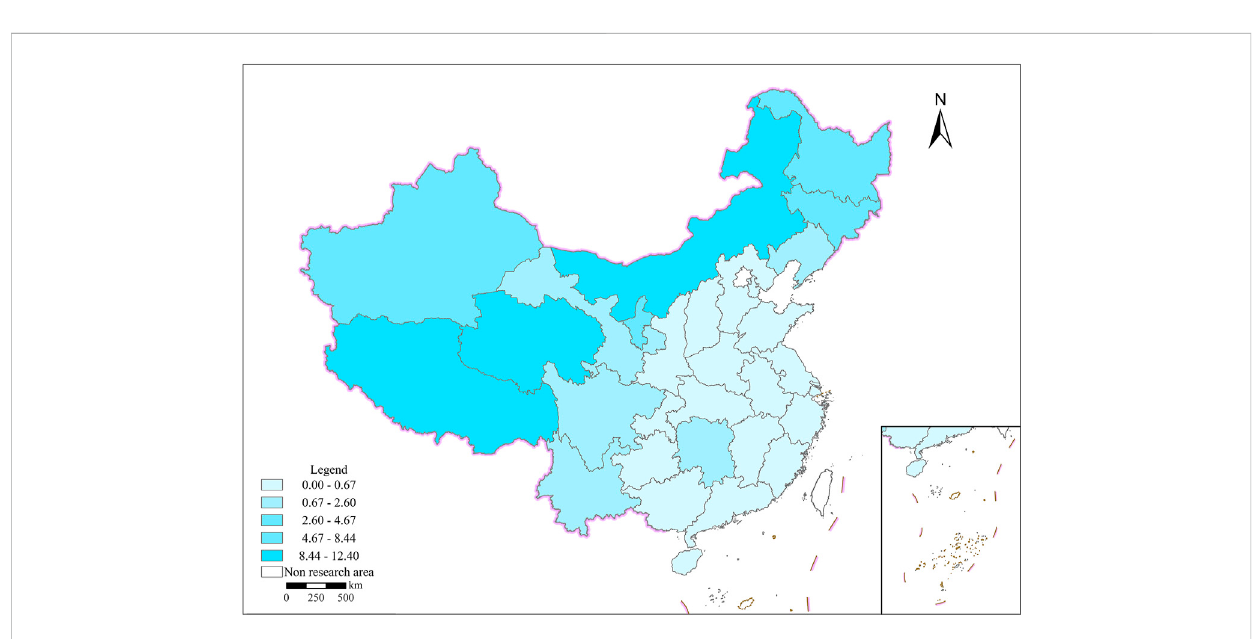
FIGURE 4 Distribution of biomass energy density per capita in rural areas in